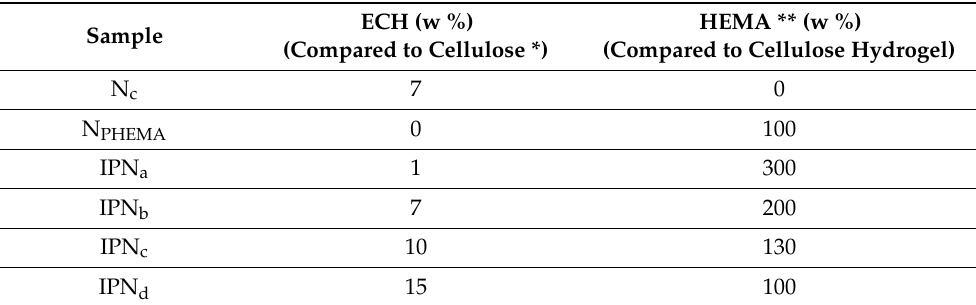
Table 1. Experimental plan for obtaining IPNs based on cellulose and PHEMA*.